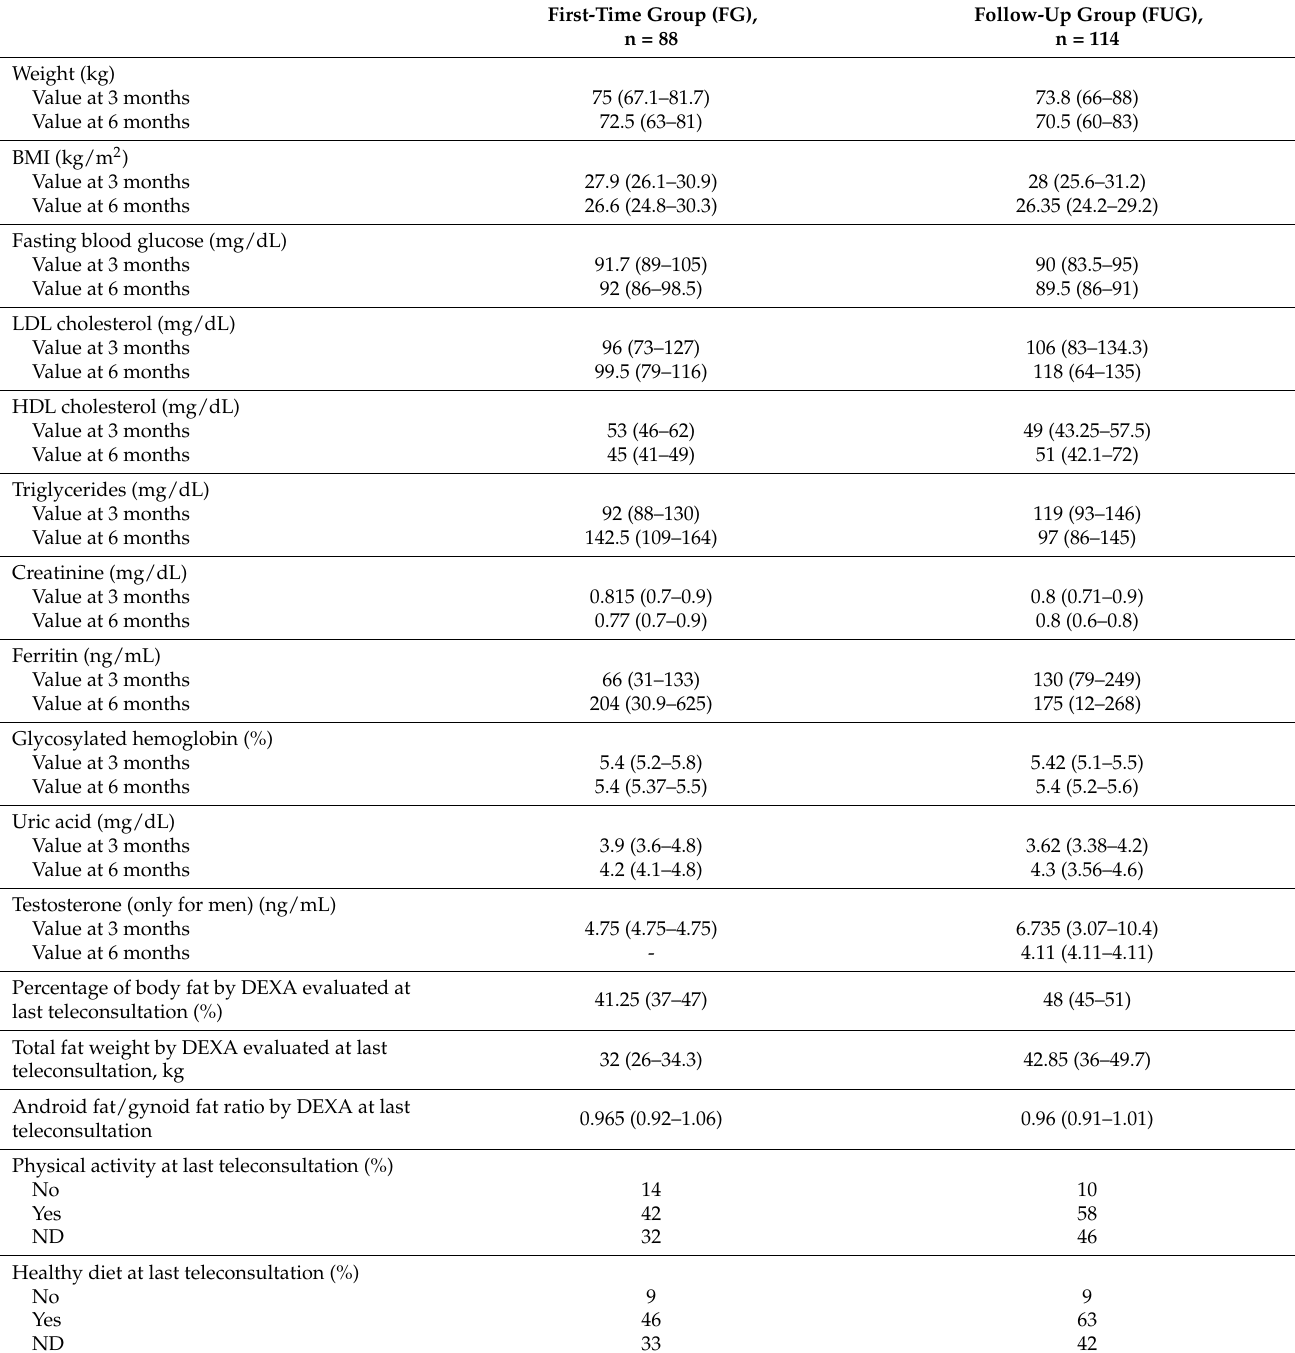
Table 3. Clinical characteristics during teleconsultations at months 3 and 6 by type of